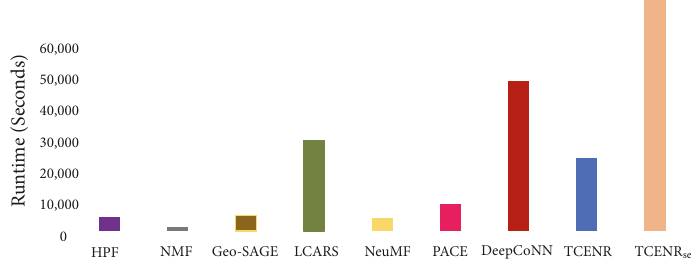
Figure 3: Runtime (seconds) of all models on the Yelp